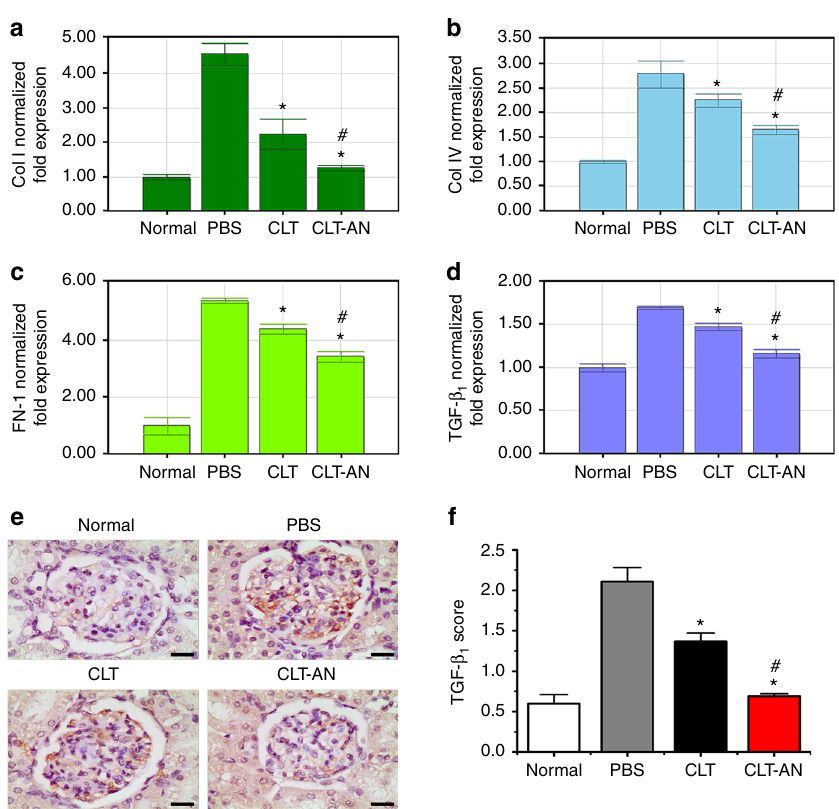
Fig. 8 Anti- fi brotic effects of CLT and CLT-AN in anti-Thy1.1 nephritic rats. a – d Real-time PCR analysis of renal mRNA levels of Col I ( a ), Col IV ( b ), FN-1 ( c ), TGF- β 1 ( d ) in anti-Thy1.1 nephritic rats on day 5 after treatment with CLT or CLT-AN. Data are shown as normalized fold expressions relative to normal group using β -actin mRNA as internal control. e Representative photomicrographs of immunostaining for TGF- β 1 in kidney tissue sections taken from anti- Thy1.1 nephritic rats on day 5 after treatment with CLT or CLT-AN. Scale bars , 20 μ m. f The levels of TGF- β 1 were semiquantitatively scored as described in Methods on the basis of immunochemical results. In panels a – d , f data are mean ± s.d. ( n = 5), results are representative of two independent experiments. * P < 0.05 vs. PBS group; # P < 0.05 vs. CLT group. Statistical signi fi cance was determined by one-way ANOVA with Tukey post hoc